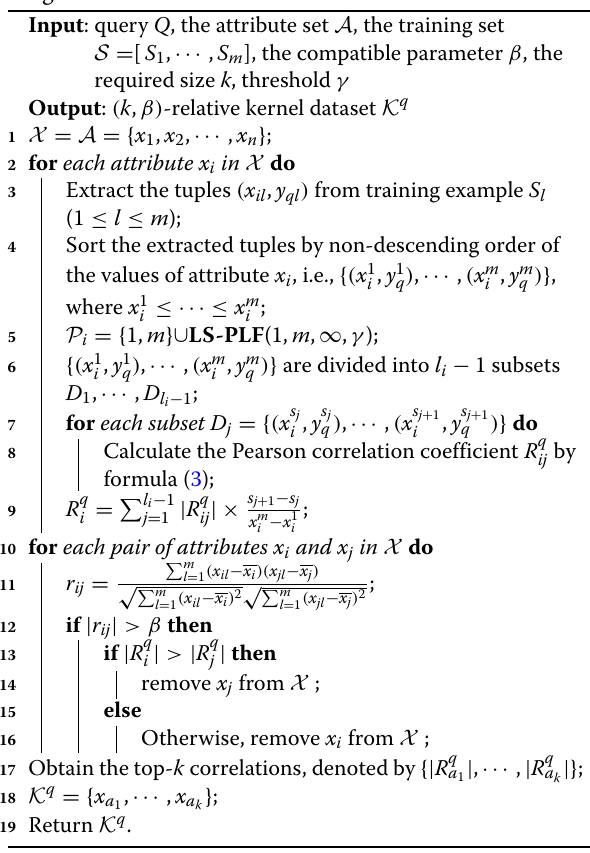
Algorithm 3: PLF-Relative Kernel Dataset Retrieving